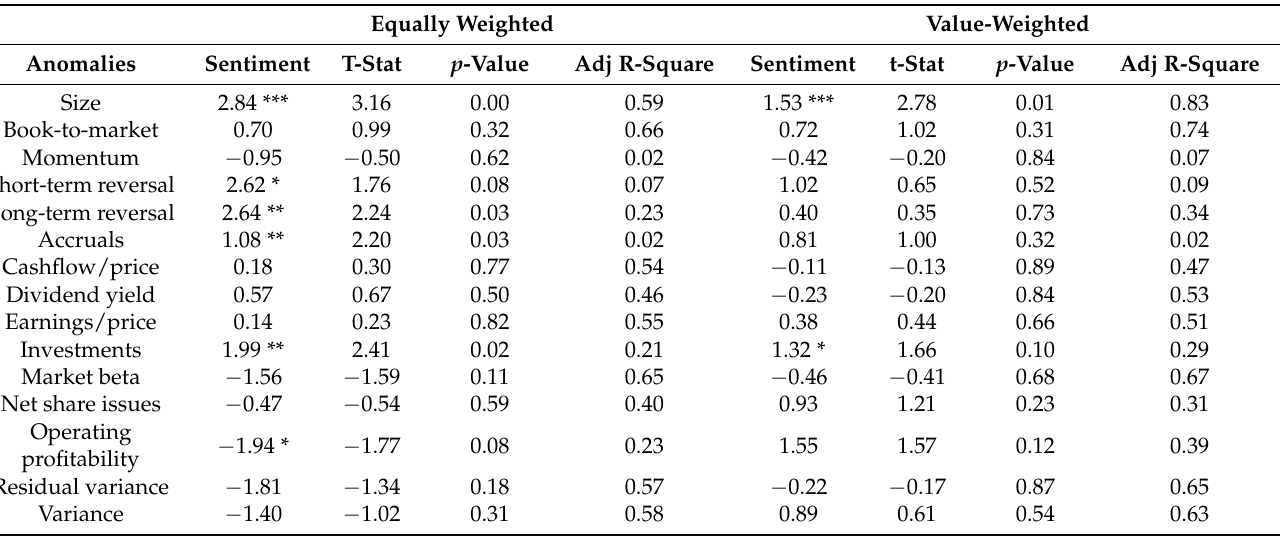
Table 11. Value-weighted vs equally weighted portfolios (US